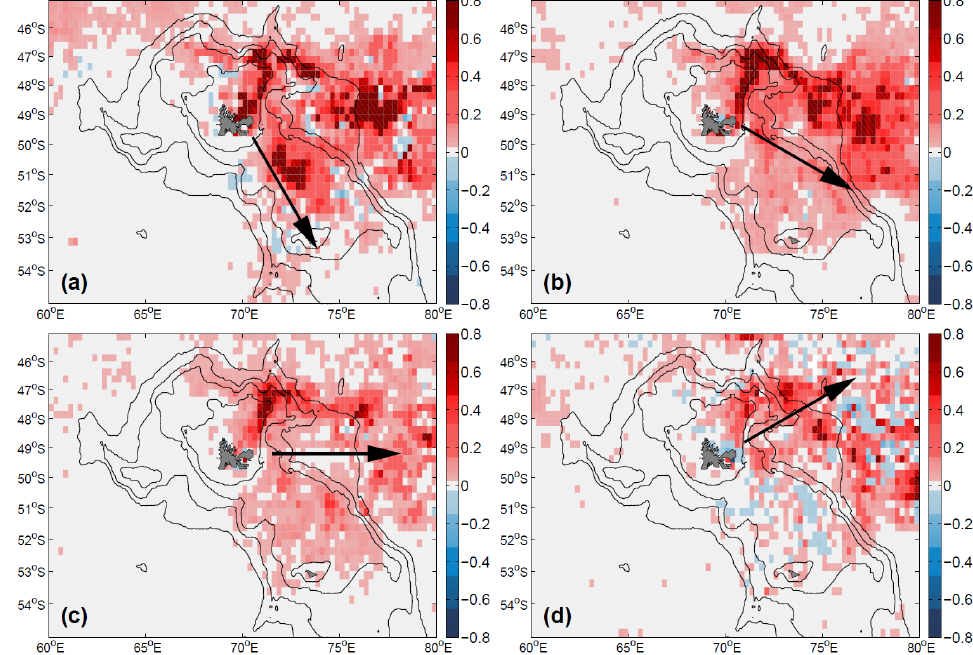
Figure 6. Chl a anomalies in mgm − 3 for the spring–summer growth season (from September through February), sorted as in Fig. 5 by prevailing wind direction for winds (a) from − 75 ◦ to − 45 ◦ , (b) from − 45 ◦ to − 15 ◦ , (c) − 15 ◦ to + 15 ◦ , and (d) + 15 ◦ to + 45 ◦ . Fields are computed based on daily data, and Chl a anomalies are computed relative to climatological monthly